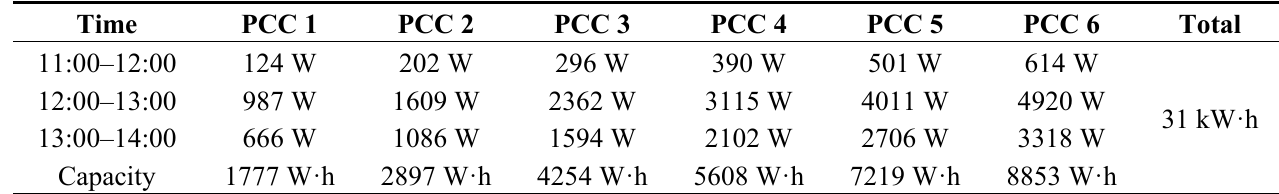
Table 2. ESS charging schedule and capacity for voltage regulation (4.0-kW PV is equally distributed).